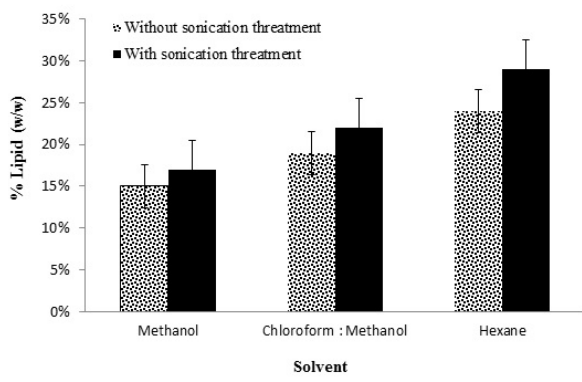
Figure 3: The yield of lipid extraction on various solvents with and no ultrasonication treatment.